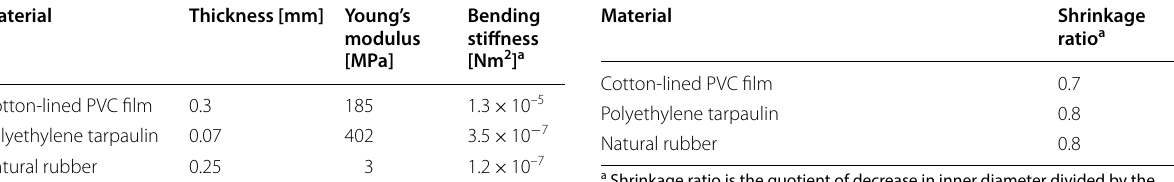
Table 2 Relationship between outer membrane material and shrinkage